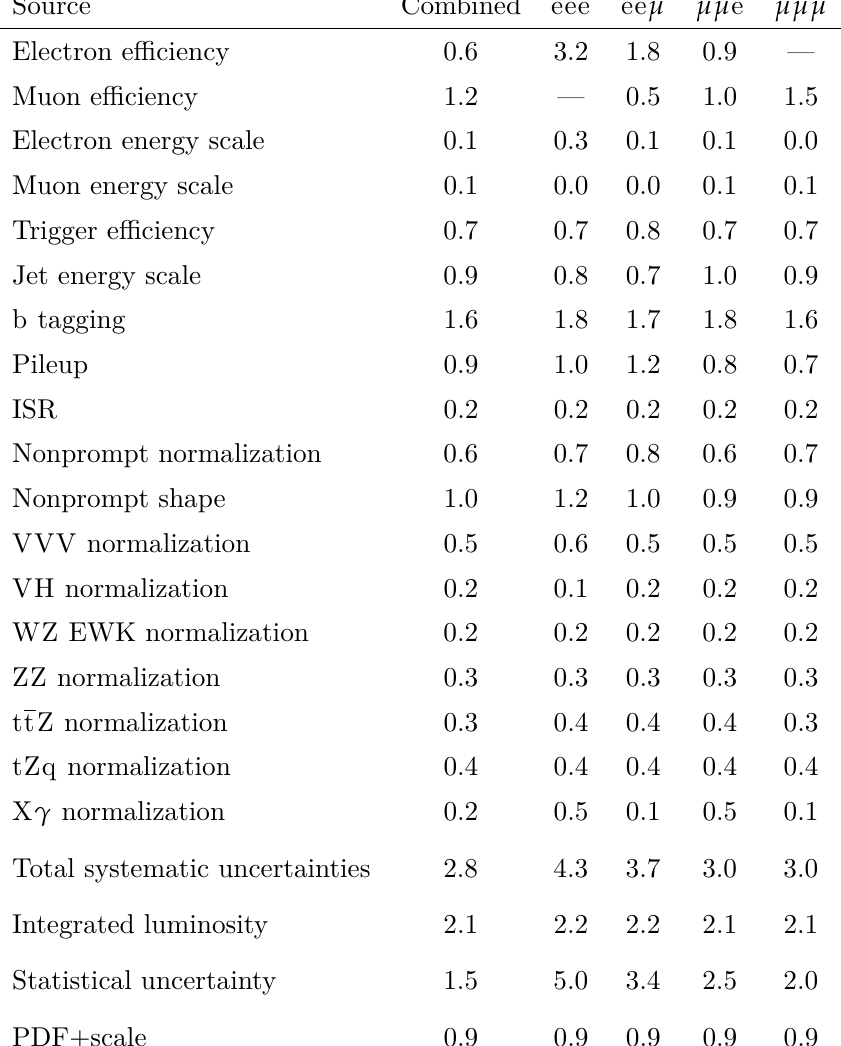
Table 7 . Summary of postfit effects of each uncertainty source in the total WZ cross section measurement separated by flavour categories. Values are given in percentage contribution to the cross section uncertainty. For the scale and PDF uncertainties that are not included in the fit, the effect on the acceptance measurements is